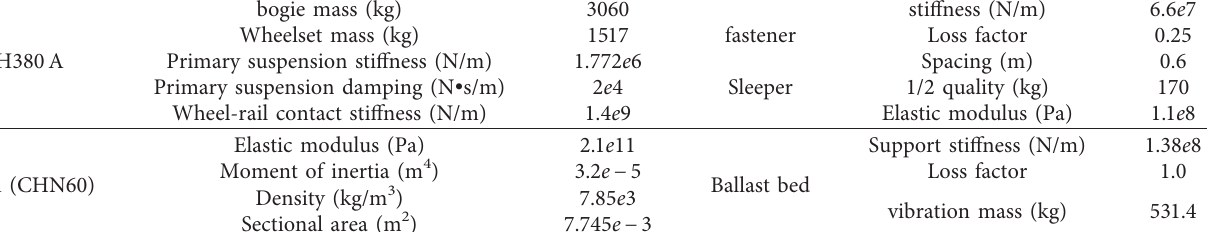
Table 2: Calculation parameters.